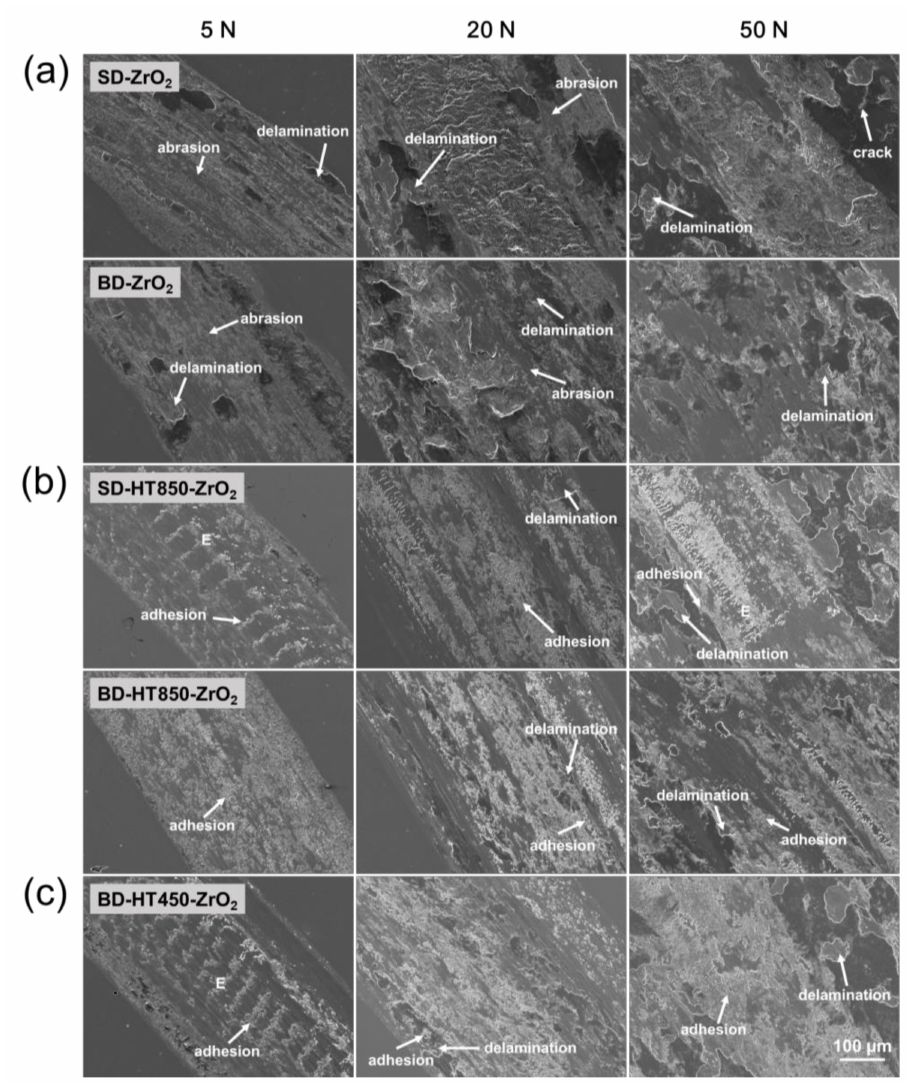
Figure 10. SEM images of the worn surface of maraging steel worn against ZrO 2 balls: ( a ) as-built, ( b ) HT850 and ( c ) HT450 heat-treated